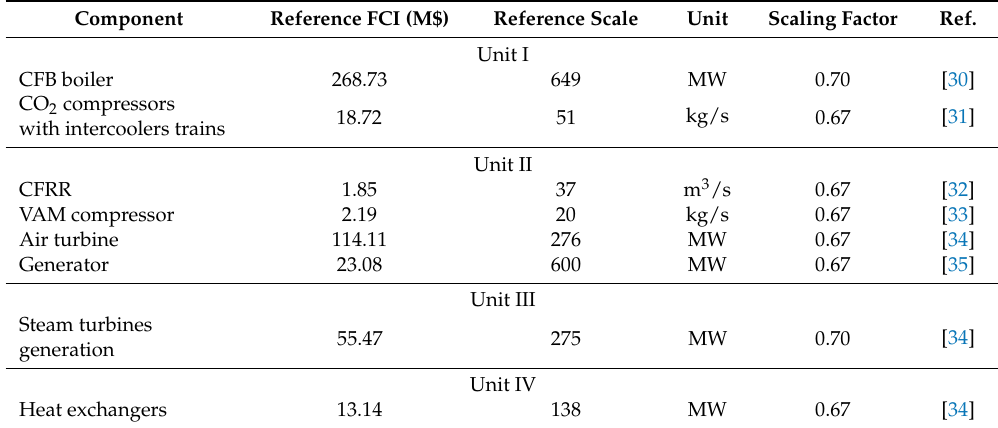
Table 5. Detailed information for FCI